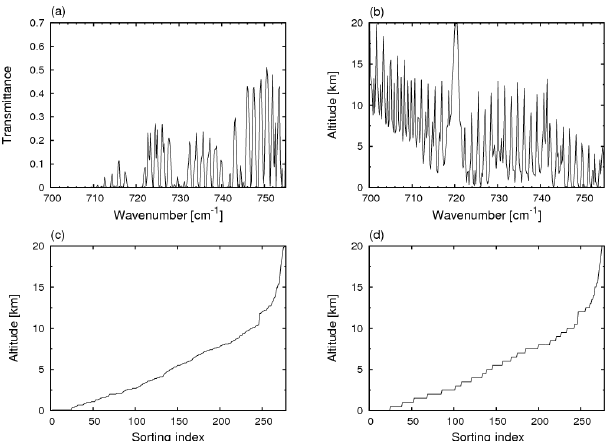
Figure 1. (a) Integrated transmittance at each channel of FTS in the wavenumber region of 700–755cm − 1 . (b) Calculated weight- ing function peak height at each channel of FTS in the same re- gion of (a) . (c) Channels are sorted based on their weighting func- tion peak heights. (d) Channels for which weighting function peak heights are in the same height range are redefined as pseudo- channels for each